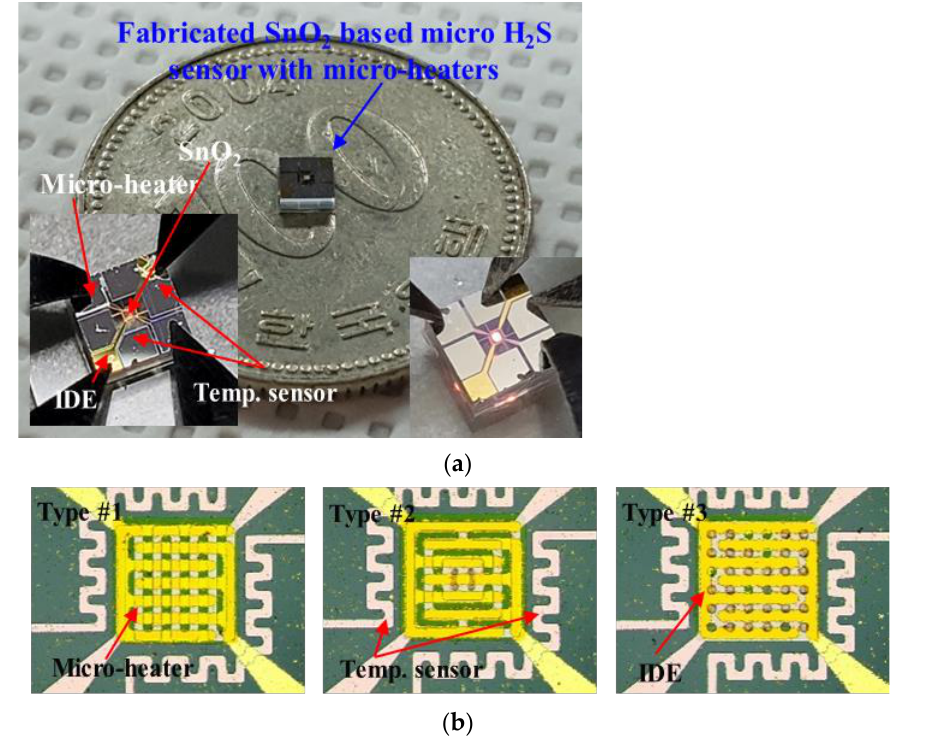
Figure 4. ( a ) Photographic and ( b ) microscopic images of the fabricated SnO 2 -based H 2 S microsensor with three types of micro-heaters.